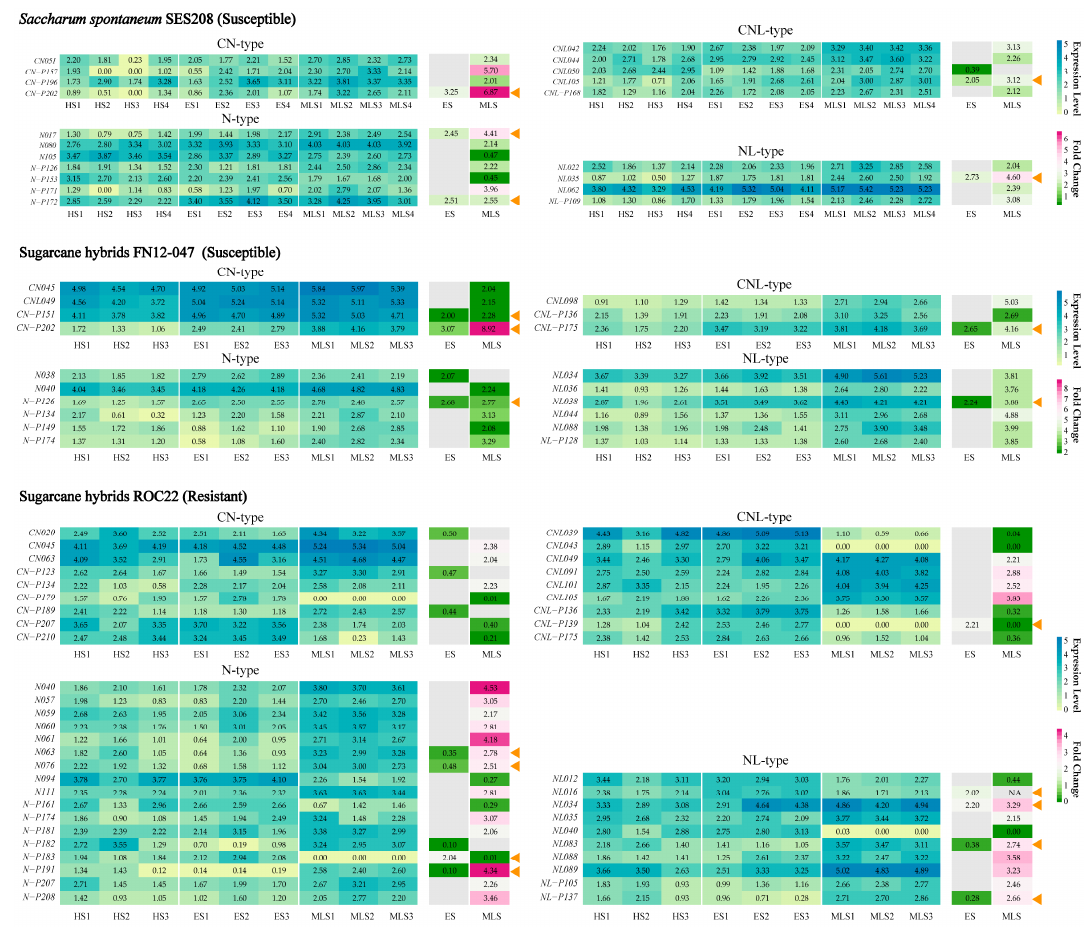
Figure 5. The NLR (differential) expression profiles responses to sugarcane leaf blight (SLB) in one Saccharum spontaneum clone SES208 and two sugarcane hybrids of ROC22 and FN12-047. ROC22 was resistant to SLB, and FN12-047 and SES208 were susceptible to SLB. Respectively, 20, 19, and 45 differentially expressed NLR genes (DENLRs) were detected in SES208, FN12-047 and ROC22. Continuous DENLRs both in the early and medium to late disease stages were marked with an orange triangle.